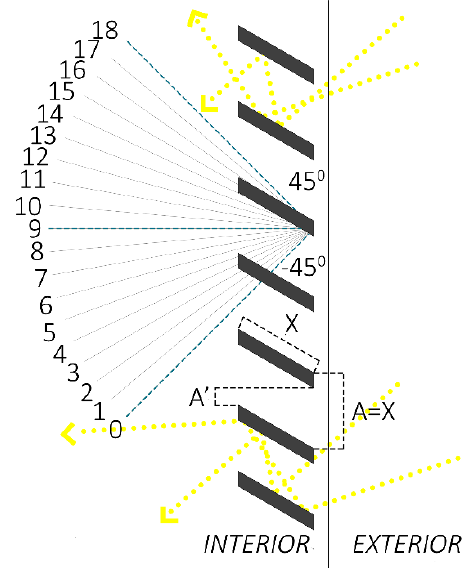
Figure 6. Illustration of the modelled adaptive horizontal shading devices.